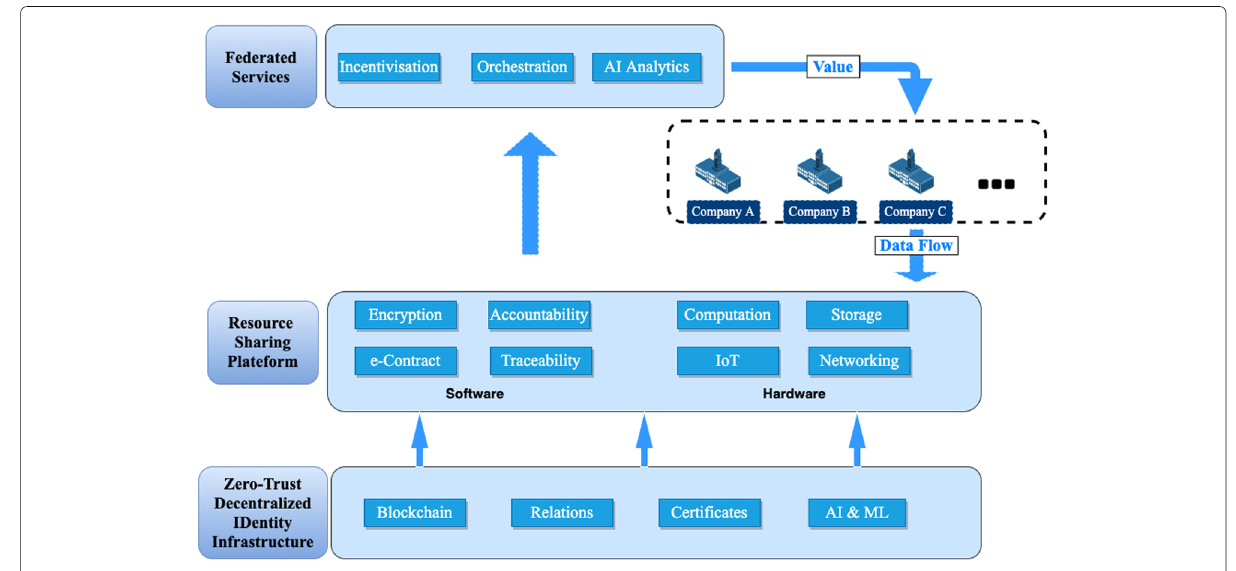
Fig. 3 Services based on distributed membership in a federation Roaming also includes the processes of mobility man- agement, authentication, authorization and accounting